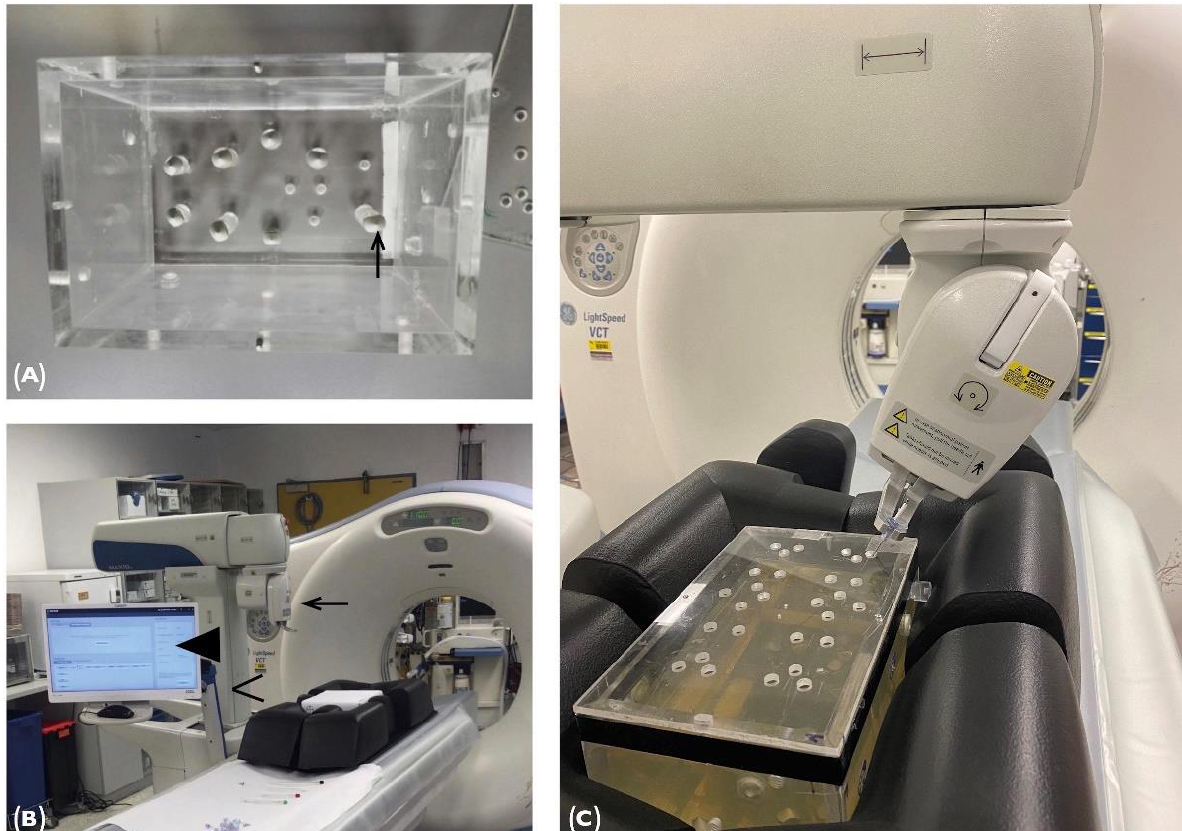
Figure 1. ( A ) The plexiglass phantom (view from above) contains 8 aluminum target points ( ↑ ). Filled with gelatin, the cover can be mounted in 4 different positions, giving a high variety of entry points. ( B ) The Maxio robot-assisted systemneeds to be docked at the CT table side on a special registration plate. The setup for puncture with the Maxio robot-assisted system contains key com- ponents such as the Maxio workstation ( ◀ ), the multi-axis electromechanical arm (<) and the end- effector ( ← ).